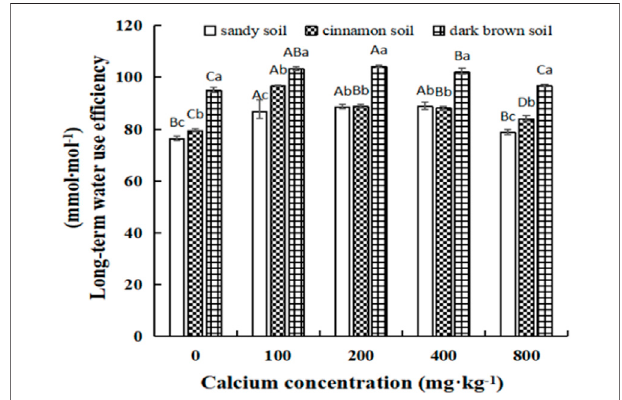
FIGURE 6 | Effects of exogenous calcium on the long-term water use ef fi ciency of Mongolian pine seedlings in different soil types. Note: Each column shows the average value ± SE, n = 3. Different capital letters indicate the difference between different calcium concentrations under the same soil type, and different lowercase letters indicate the difference between different soil types under the same calcium concentration ( p <